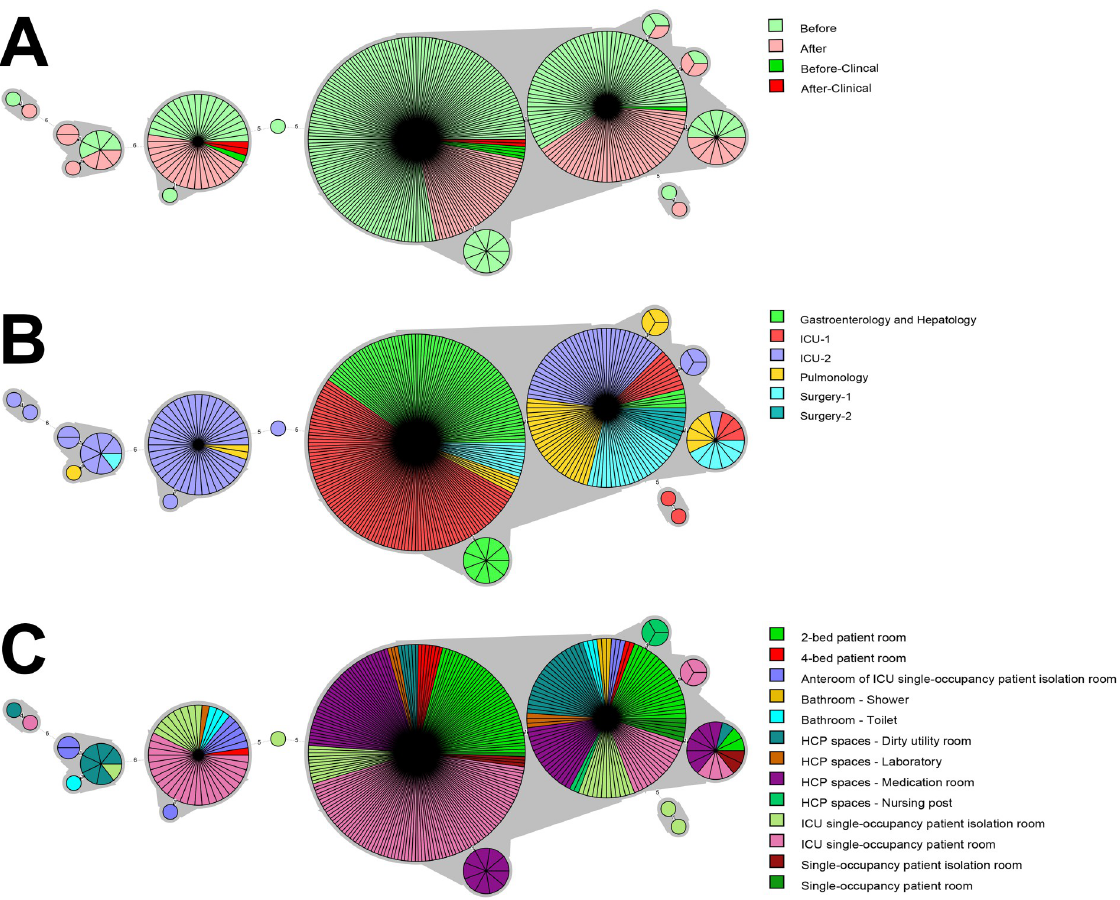
Fig 2. Minimum-spanning trees of VIM-PA isolates A) found before or after the intervention, and their B) ward of origin and C) room type, based on MLVA. Isolates found at the moment of the intervention are categorized as “before” isolates. Clinical isolates are indicated in panel A. Each circle represents a genotype, and depicts the number of isolates of that genotype. Numbers on connecting lines indicate the number of differing markers between genotypes. Gray shading indicates clusters of related genotypes differing in only a single MLVA